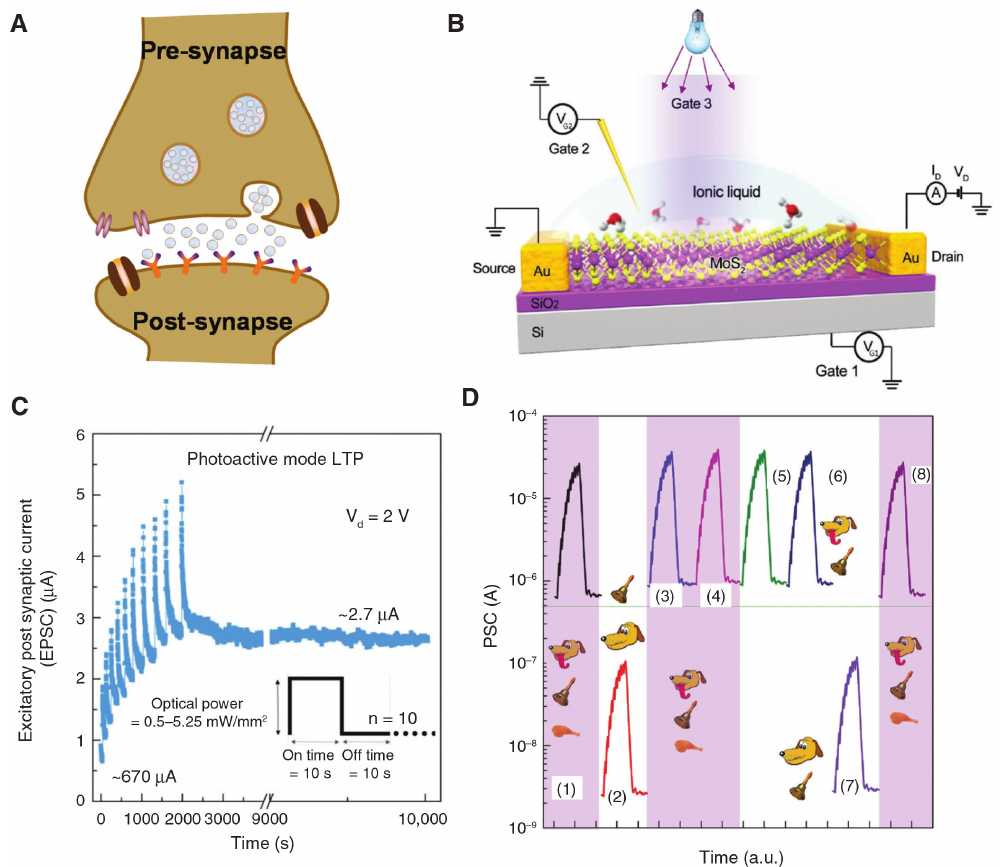
Figure 7: The application of photonic memristor as an artificial synapse. (A) Schematic of biological synaptic transmission. Reproduced with permission [22]. Copyright 2019, Wiley-VCH. (B) The proposed multi- gated architecture of analogous artificial MoS synapses wherein the Gate 3 serves as the optical stimulus. (C) Increment in long-term 2 potentiation (LTP) strength as a function of persistent training in photoactive-mode (D) Classical conditioning Pavlov’s dog experiment. (B–D) Reproduced with permission [76]. Copyright 2018,